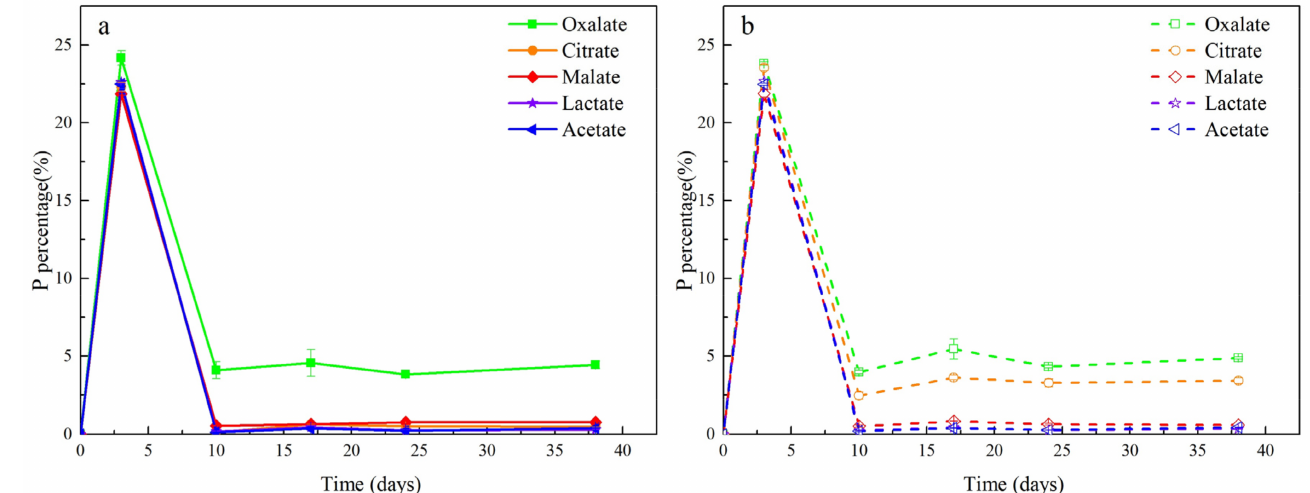
Figure 6. Dissolved P release as a percent of total P in soil under ( a ) biotic and ( b ) abiotic conditions with different LMWOAS amendments in unremediated soils.